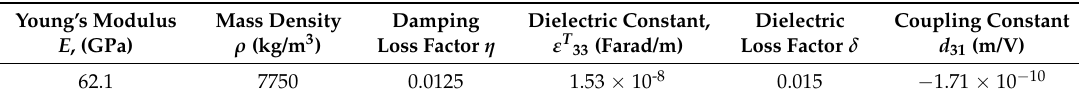
Table 3. Material properties of PZT